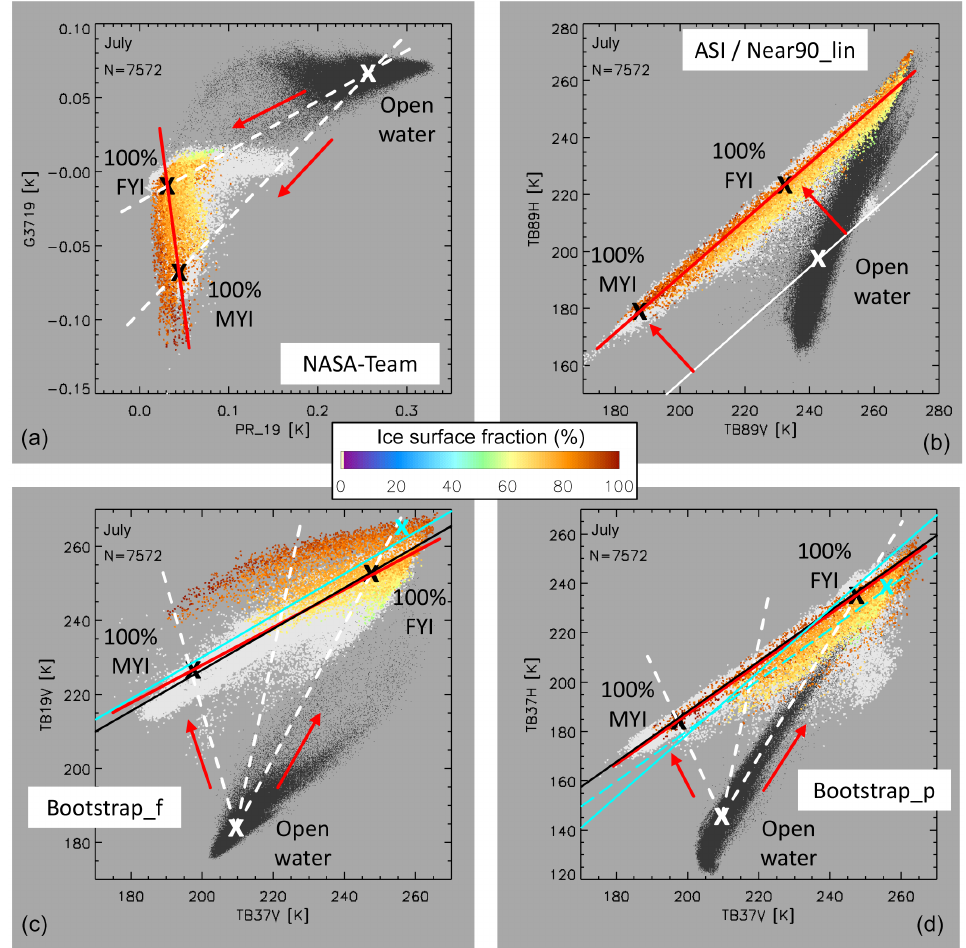
Figure 6. Parameter spaces for NASA Team (a) , ASI/Near90_lin (b) , Bootstrap_f (c) , and Bootstrap_p (d) algorithms. Each image contains AMSR-E brightness-temperature data for the respective space for July 2009, color-coded with the contemporary MODIS ice-surface fraction for cloud cover < 5% and MODIS sea-ice concentration > 90%. Black and white dots denote winter (10 February 2007) Arctic brightness temperatures for 0 and > 90% NT2 sea-ice concentration, respectively. White and black crosses denote open-water and sea-ice tie points for winter, respectively (Ivanova et al., 2015). Red arrows show the direction of the sea-ice concentration increase. Red lines connect first-year ice (FYI) and multiyear ice (MYI) tie points, and are referred to as ice lines in the text. For white, black, and cyan lines and crosses, see text in Sect.